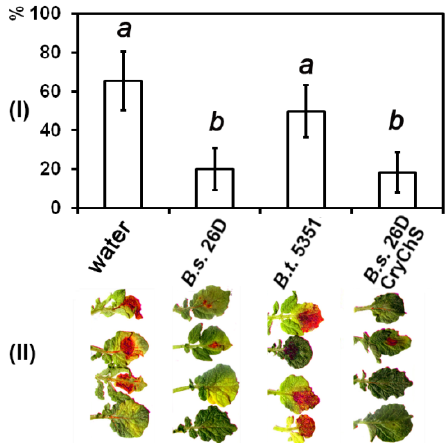
Figure 1. The influence of Bacillus strains on late blight disease symptoms on the potato leaves on 10th day after P. infestans inoculation. ( I ) Percentage of leaf area with late blight symptoms. Data represented as mean values ± standard error, values followed by the same alphabet are not significantly different from each other according to Student’s test p < 0.05. ( II ) Late blight lesions highlighted using ImageJ software (red areas on leaves).